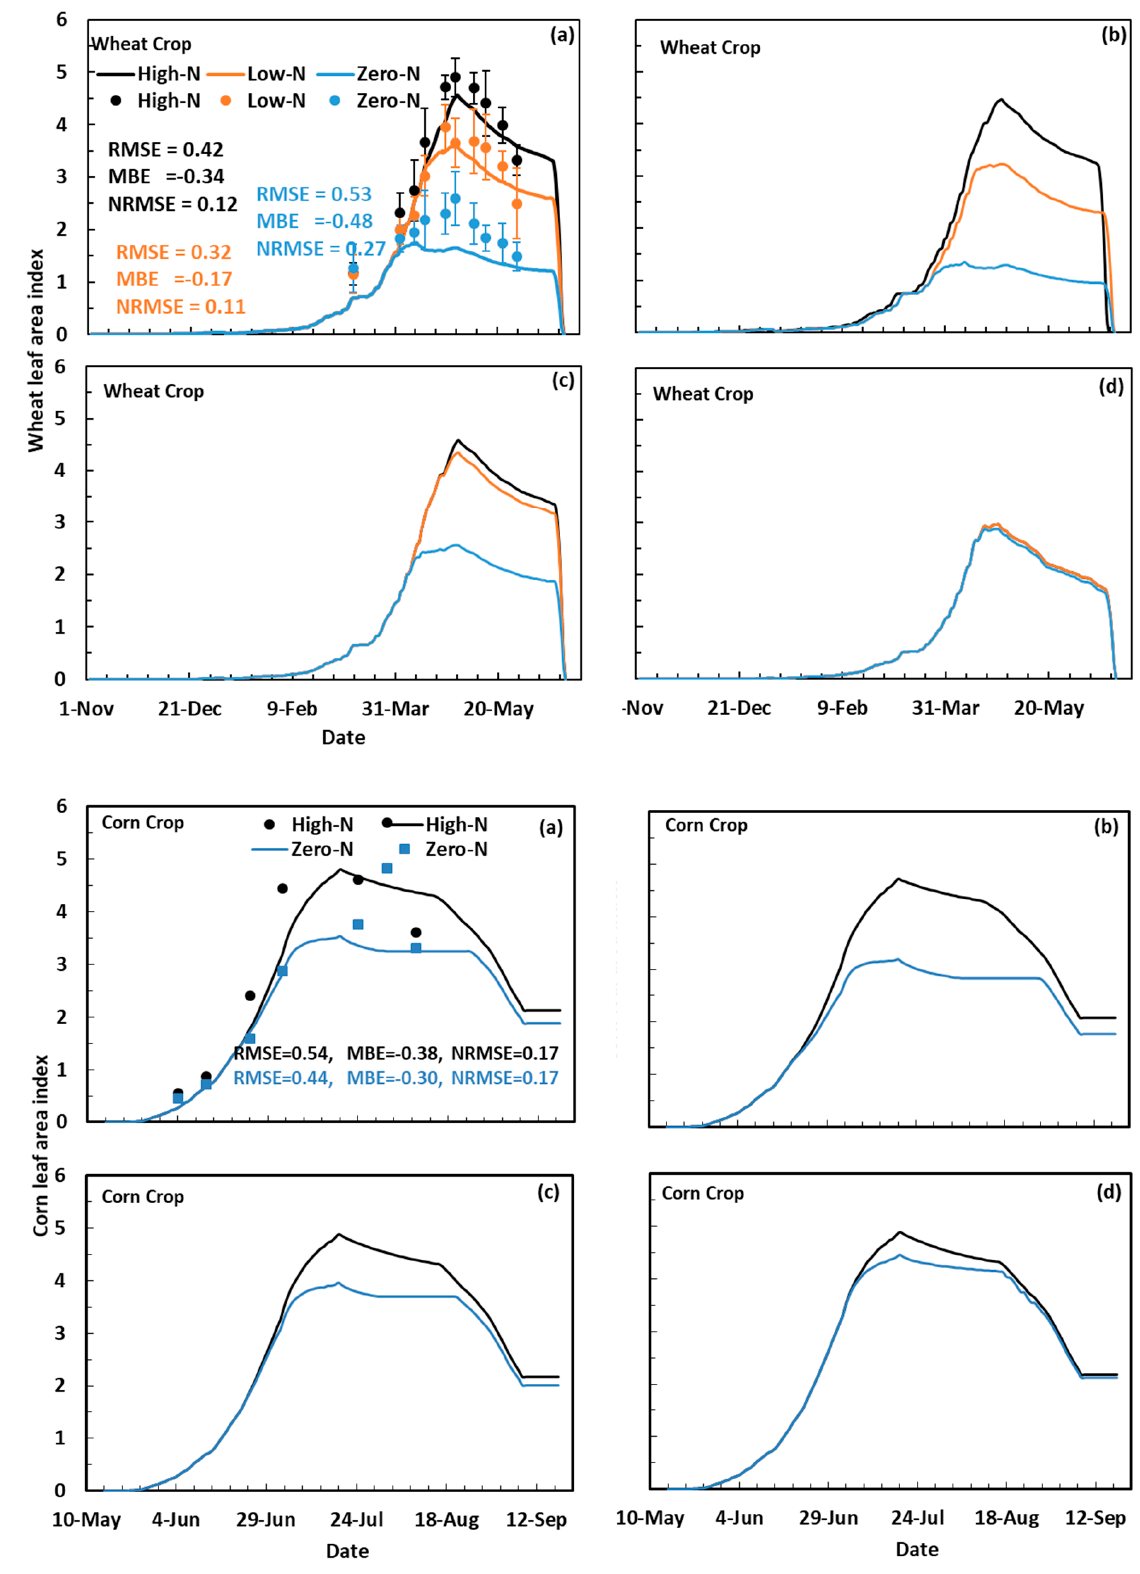
Figure 7. Leaf area index for the wheat and corn growing seasons under the: ( a ) 100%, ( b ) 125%, ( c ) 75% and ( d ) 50% rainfall scenarios.